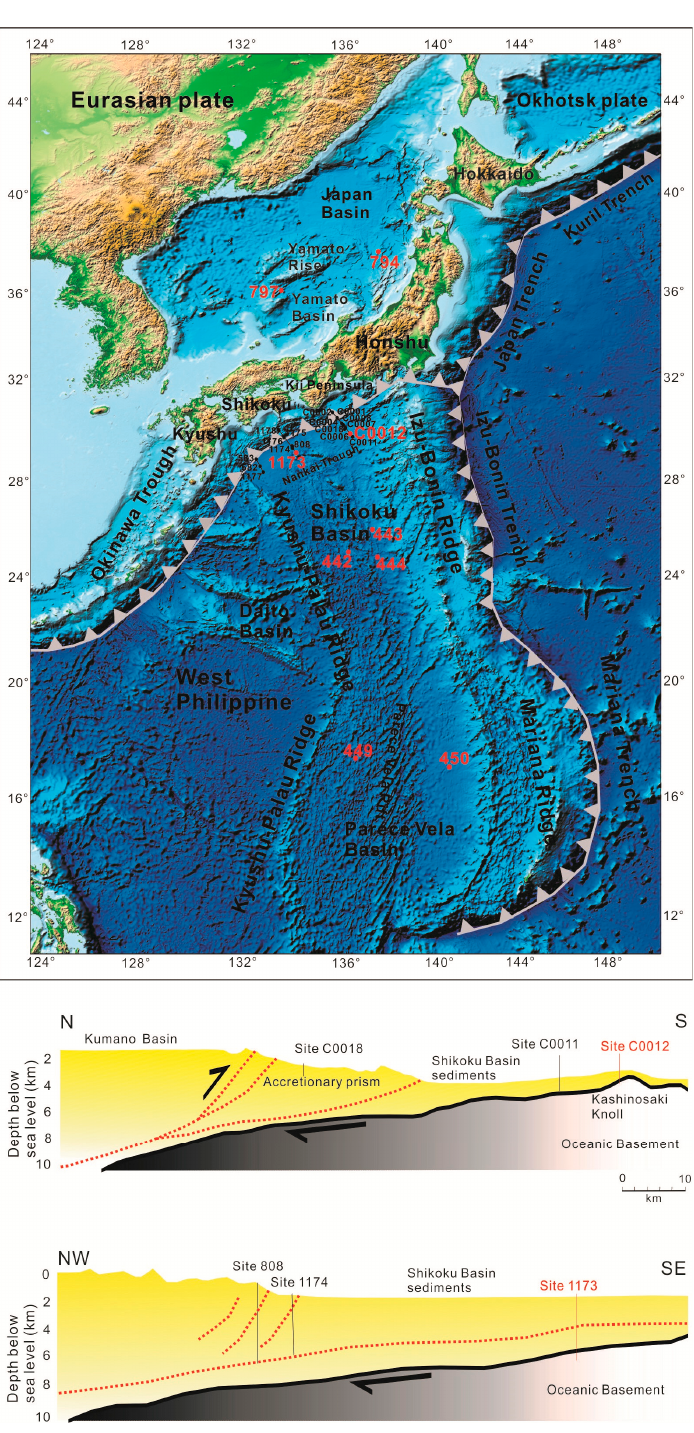
Figure 2. Simplified geotectonic map (cross-section) of the Shikoku Basin in the Philippine plate with the locations of the oceanic drilling cores within the Shikoku Basin and the Nankai Trough on the subducting Philippine Sea plate. Seismic in-line section showing locations of Sites C0011, Site C0012, Site 1173, Site 1174, and Site 808 (modified after Reference [31]).